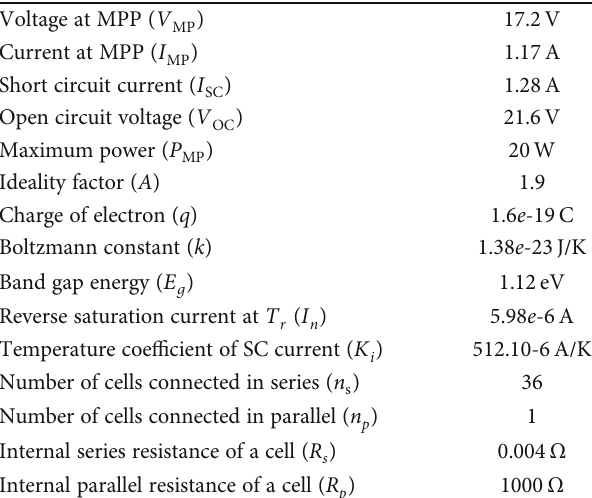
Table 1: SR-20 PV panel speci fi cations (A.M.1.5, 1kW/m 2 , 25 ° C) and identi fi ed parameters of the adjusted